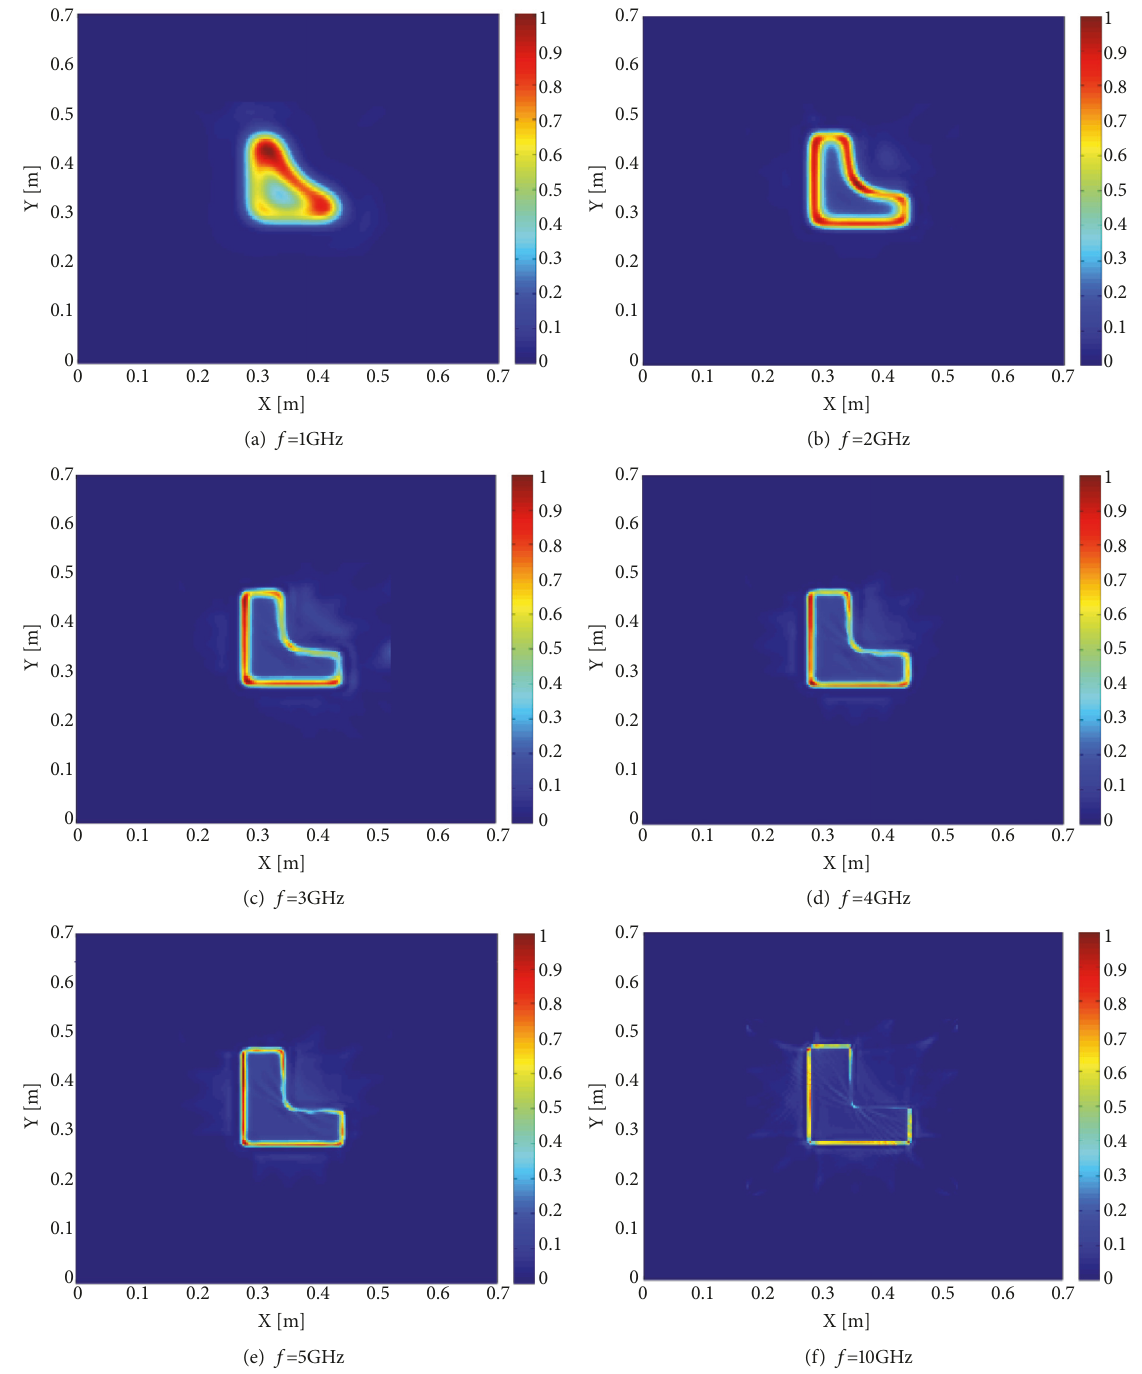
Figure 14: Imaging an L-shape object by 𝑀 =16 transmitters and 𝑁 =64 receivers ( 𝑓 is the excitation frequency of the sources).